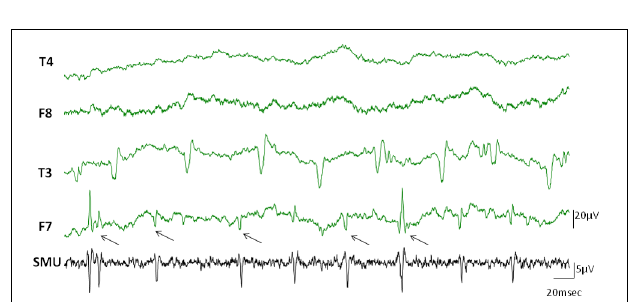
Macro-EMEGs of the same SMU. Clear overlapping shows the occurrence of the potentials without a time delay, indicating cross-talk. Again, F7 electrode had the greatest interference.